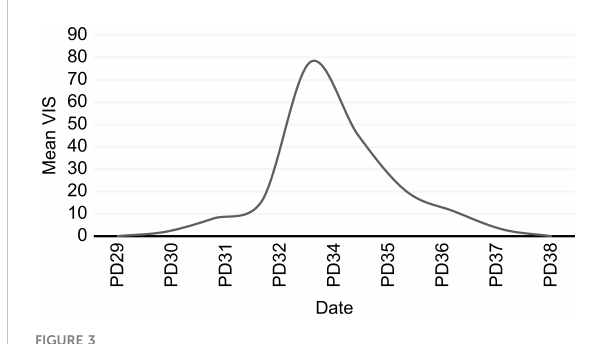
FIGURE 3 The trend of the mean VIS. #PD, postoperative day; *VIS, Vasoactive – Inotrope Scoring. VIS= dopamine dose (µg/kg/min) + dobutamine dose (µg/kg/min) + 100* epinephrine dose (µg/kg/min) + 10*milrinone dose (µg/kg/min) + 10,000* vasopressin dose (U/kg/ min) + 100* norepinephrine dose (µg/kg/min). The hourly doses of the following inotropic and vasoactive medications were recorded every day: dopamine, dobutamine, epinephrine, norepinephrine, milrinone, and vasopressin. The mean VIS was obtained by averaging the hourly scores during 24-hr